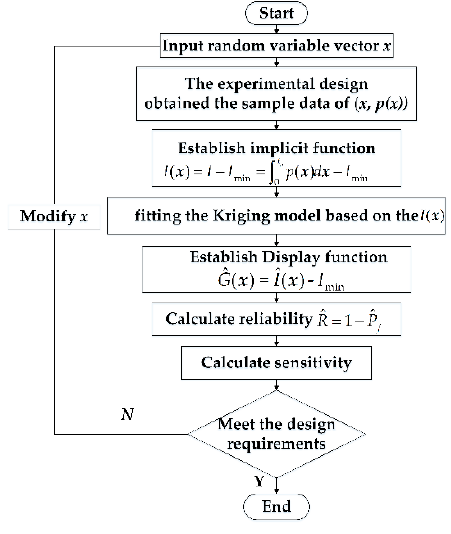
Figure 7. Reliability simulation flow chart of the pyrotechnic igniter.